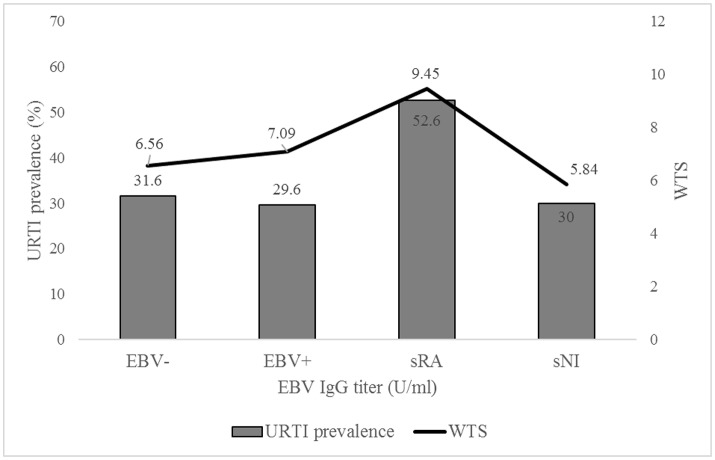
URTI prevalence and WURSS-21 total score (WTS) depending on EBV serostatus (EBV–: EBV-seronegative [n = 253], EBV+: EBV-seropositive [n = 392], sRA: suspected reactivation [n = 19], sNI: suspected new infection [n = 5]). Values are expressed as means.